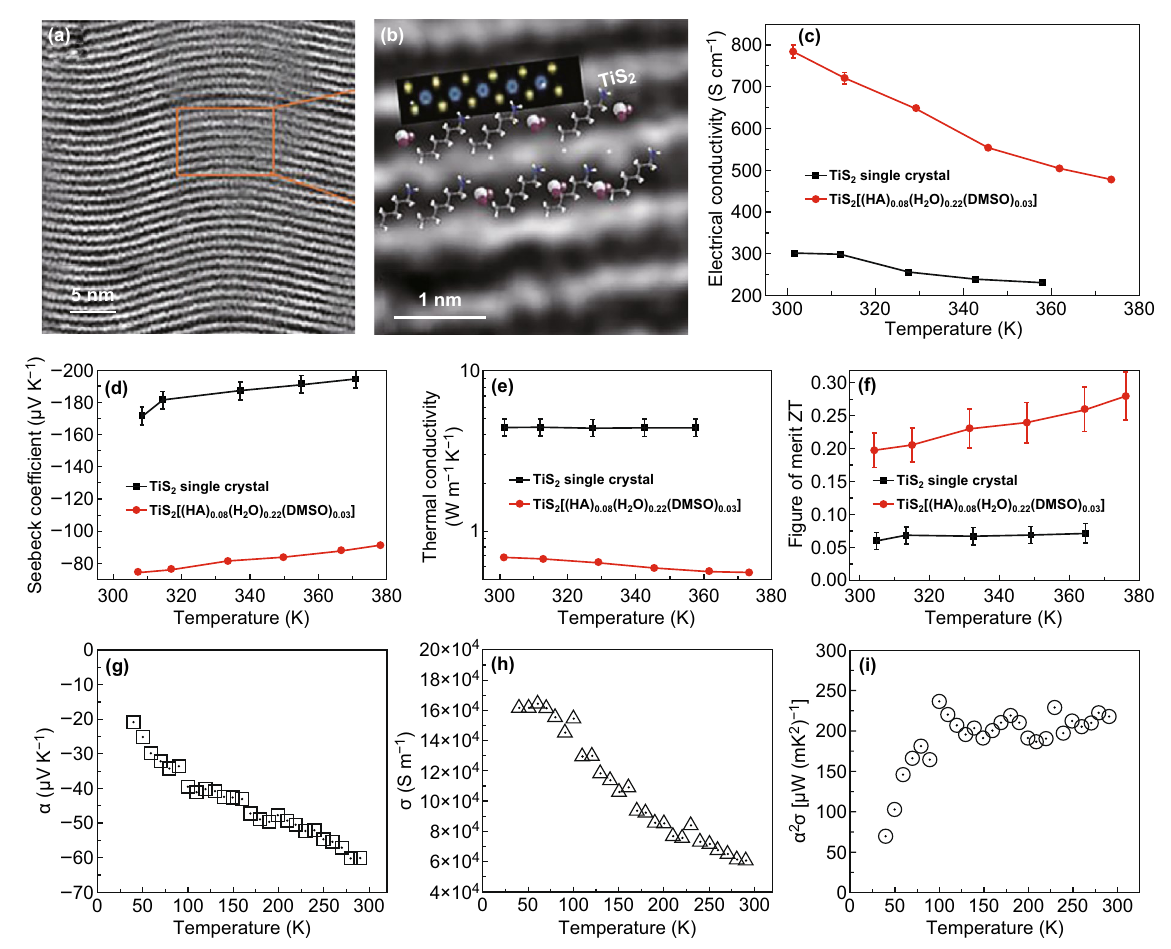
Fig. 8 a , b HAADF-STEM image of the TiS 2 [(HA) x (H 2 O) y (DMSO) z ] hybrid superlattice, c electrical conductivity, d Seebeck coefficient, e thermal conductivity, and f ZT of the TiS 2 [(HA) x (H 2 O) y (DMSO) z ] hybrid superlattice. Reproduced with permission from Ref. [186]. Copyright 2015, Springer Nature. g Seebeck coefficient, h electrical conductivity, and i power factor of the TiS 2 nanosheet assembled thin film. Repro- duced with permission from Ref. [183]. Copyright 2017, American Chemical